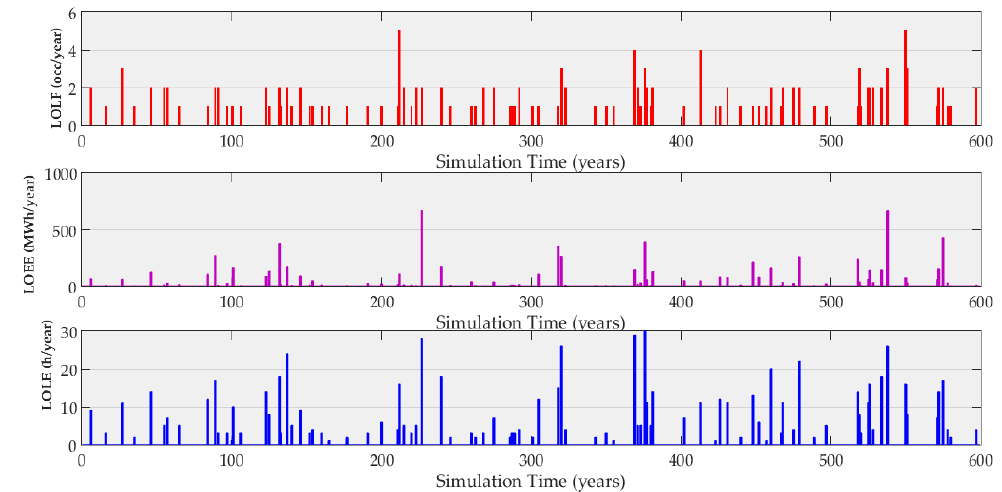
Figure 11. Simulation of reliability indices with (600) sampling years.